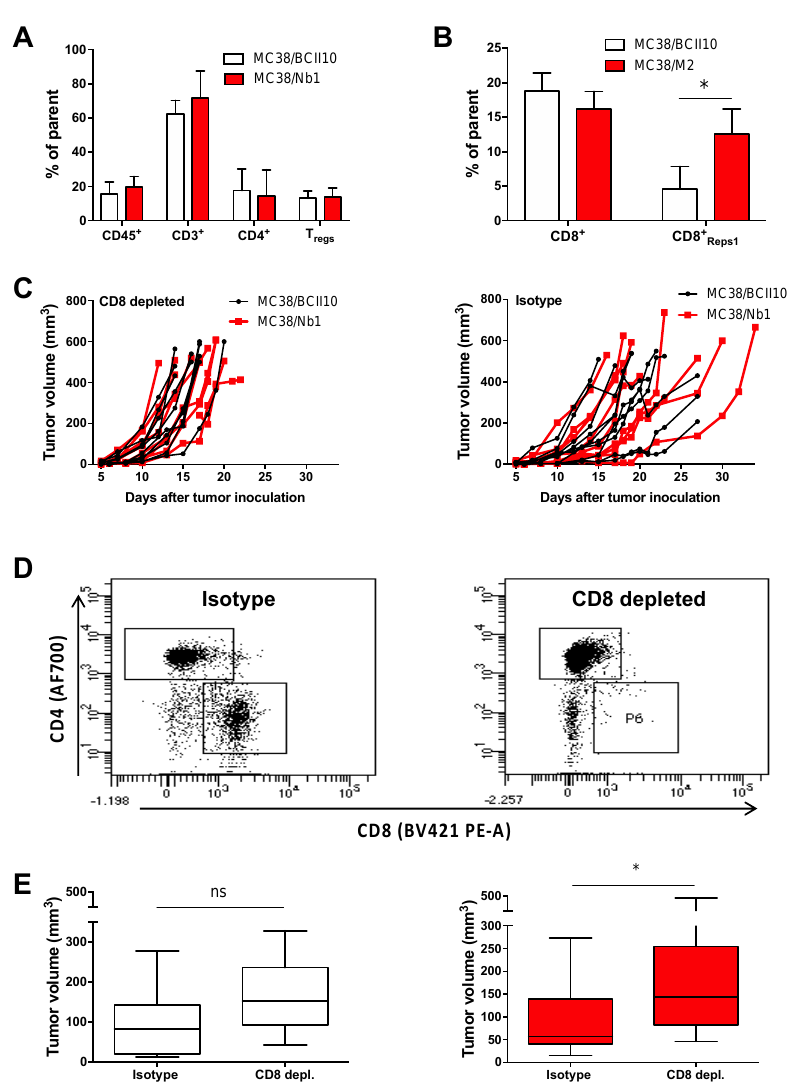
Figure 7. Production of Nb1 in the TME of MC38 tumors increases the percentage of tumor-specific CD8 + T cells. ( A , B ) MC38/BCII10 or MC38/Nb1 cells were subcutaneously injected in C57BL/6 mice. Growth of MC38 tumors was monitored on a daily basis. Tumors with a size of 534 ± 68 mm 3 were isolated, reduced to single-cell suspensions and subjected to flow cytometry analysis. The bar graphs show the percentage of immune cells (CD45.2 + ) and, within these immune cells, the percentage of CD3 + T cells, which are further subdivided in CD4 + and CD8 + T cells. Within the CD4 + T cells, we further analyzed Tregs (CD25 high CD127 − ). Within the CD8 + T cells, Reps1-specific cells were analyzed. The bar graphs summarize the results as mean ±SEM of two independent experiments ( n = 2, mpc = 10). Statistical analysis was performed by the Student’s t -test, and asterisks represent a p -value < 0.1 (*). ( C – E ) MC38/BCII10 or MC38/Nb1 cells were injected subcutaneously in C57BL/6 mice. Mice were injected intraperitoneally with 50 µg CD8-depleting or isotype-matched antibodies before tumor cell inoculation. Growth of MC38 tumors was monitored on a daily basis. ( D ) Depletion of CD8 + T cells was confirmed on splenocytes using flow cytometry. The dot plots show the presence of CD4 + and CD8 + T cells in mice treated with an isotype-matched control antibody, while only CD4 + T cells were detected in mice treated with CD8-depleting antibodies. The dot plots shown are representative of two experiments ( n = 2, mpc = 5). ( E ) The box graphs show the range, mean and standard deviation of the tumor sizes on day 13 in the presence or absence of CD8 + T cells in MC38/BCII10 or MC38/Nb1 tumors. The box and whisker graph summarizes the results of two independent experiments ( n = 2, mpc = 5). Statistical analysis was performed by the Student’s t -test and asterisks represent a p -value < 0.05 (*).